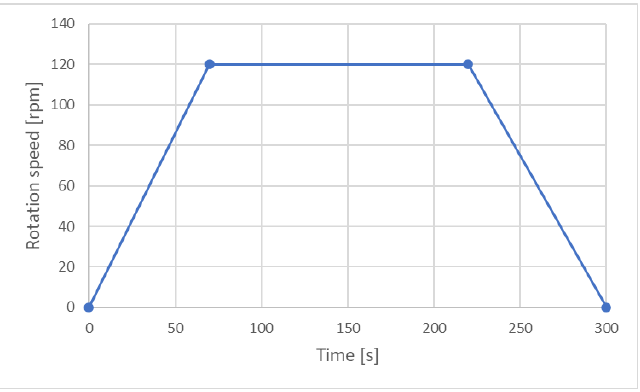
Figure 1. Rheological measurement procedure.